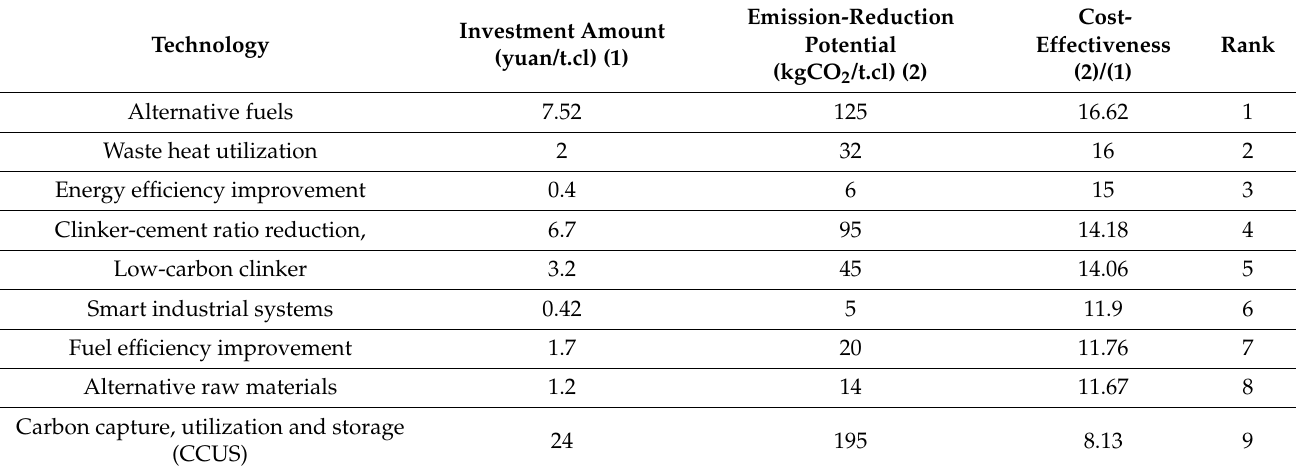
Table 4. Investment and potential of emission-reduction technologies.